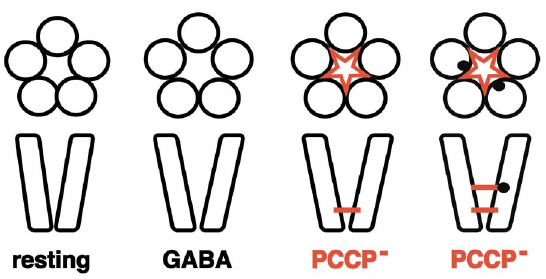
Figure 11. Hypothetical model for the mechanism of action of PCCP 2 . Mutation of residues a 1 V256 and a 1 T261 to cysteine alters strongly the apparent affinity for channel inhibition by PCCP 2 . The fact that MTSET + can only react with cysteines introduced in M2 in the presence of GABA indicates that GABA widens the pore. For the mutations a 1 V256C and a 1 T260C the affinity for PCCP 2 is strongly increased after MTSET + treatment. MTSET + reaction is prevented by PCCP 2 . This together implies these residues in PCCP 2 binding. Introduction of two positive charges by reaction with MTSET + further up in the channel leads to additional binding sites for PCCP 2